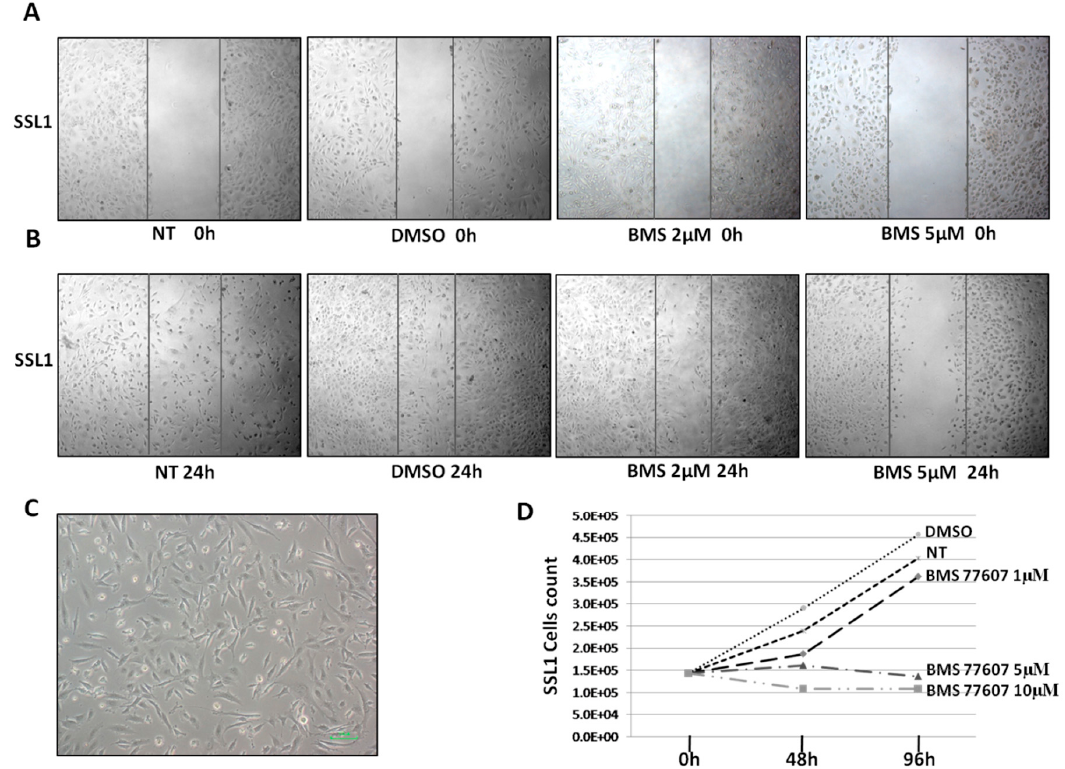
Figure 3. Standard scratch assay: SSL1 cells were grown to confluence, scratched using a sterile tip, and then treated with 2 or 5 µ M BMS. Cells with no treatment (NT) or treated with DMSO were used as controls. ( A ) Cells were photographed at t = 0 h and ( B ) after 24 hours of treatment (t = 24 h) in the same location. BMS reduced cell migration. ( C , D ) Proliferation assay: SSL1 cells were treated with 1 µ M, 5 µ M or 10 µ M BMS. Cells showed a lower proliferation at 5 µ M and 10 µ M of BMS. NT cells and DMSO were used as